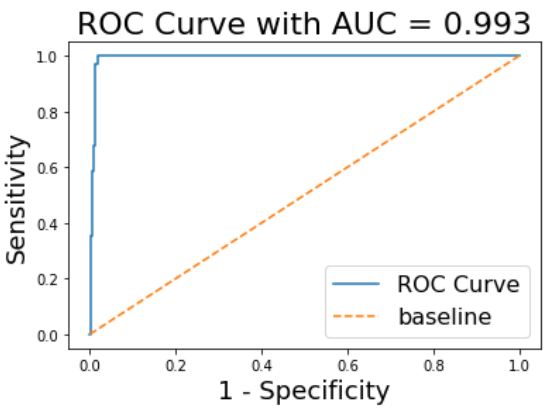
Figure 10. ROC and AUC